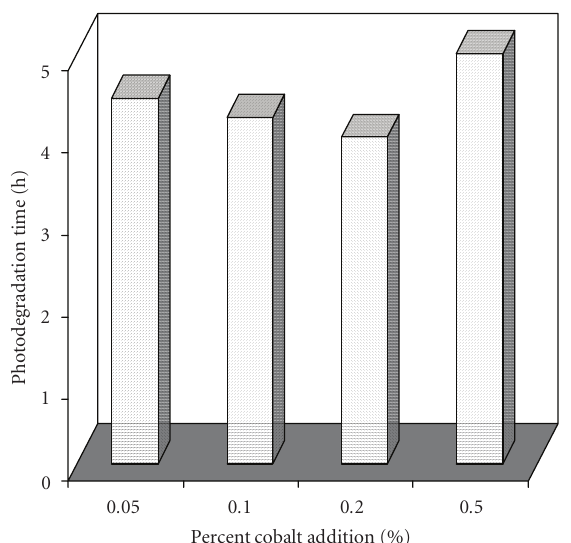
Figure 6: Time required for the photodegradation of 1 mM 4- chlorophenol in aqueous suspensions of Co( x %)-TiO 2 as a function of the amount of cobalt ( x %). The final calcination temperature was 400 ◦ C for 30 minutes.